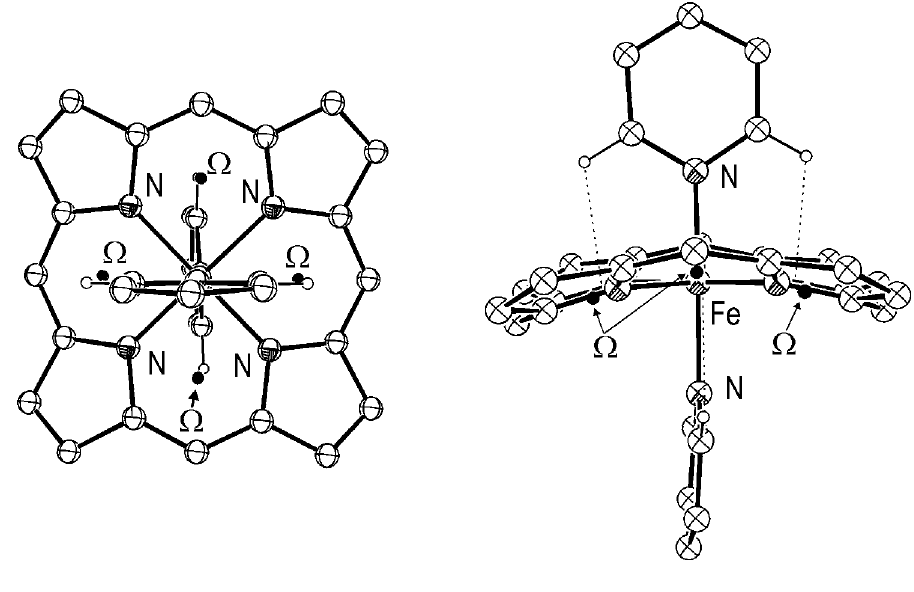
Figure 6. Crystal structure of CPOEFE10 with parallel orientation of pyridine ligands. Two orthogonal projections of molecule are shown. Dashed lines represent C − H ··· π interactions between four hydrogen atoms and two chelate rings. Some of atoms have been omitted for clarity. Coordinates are taken from CSD.